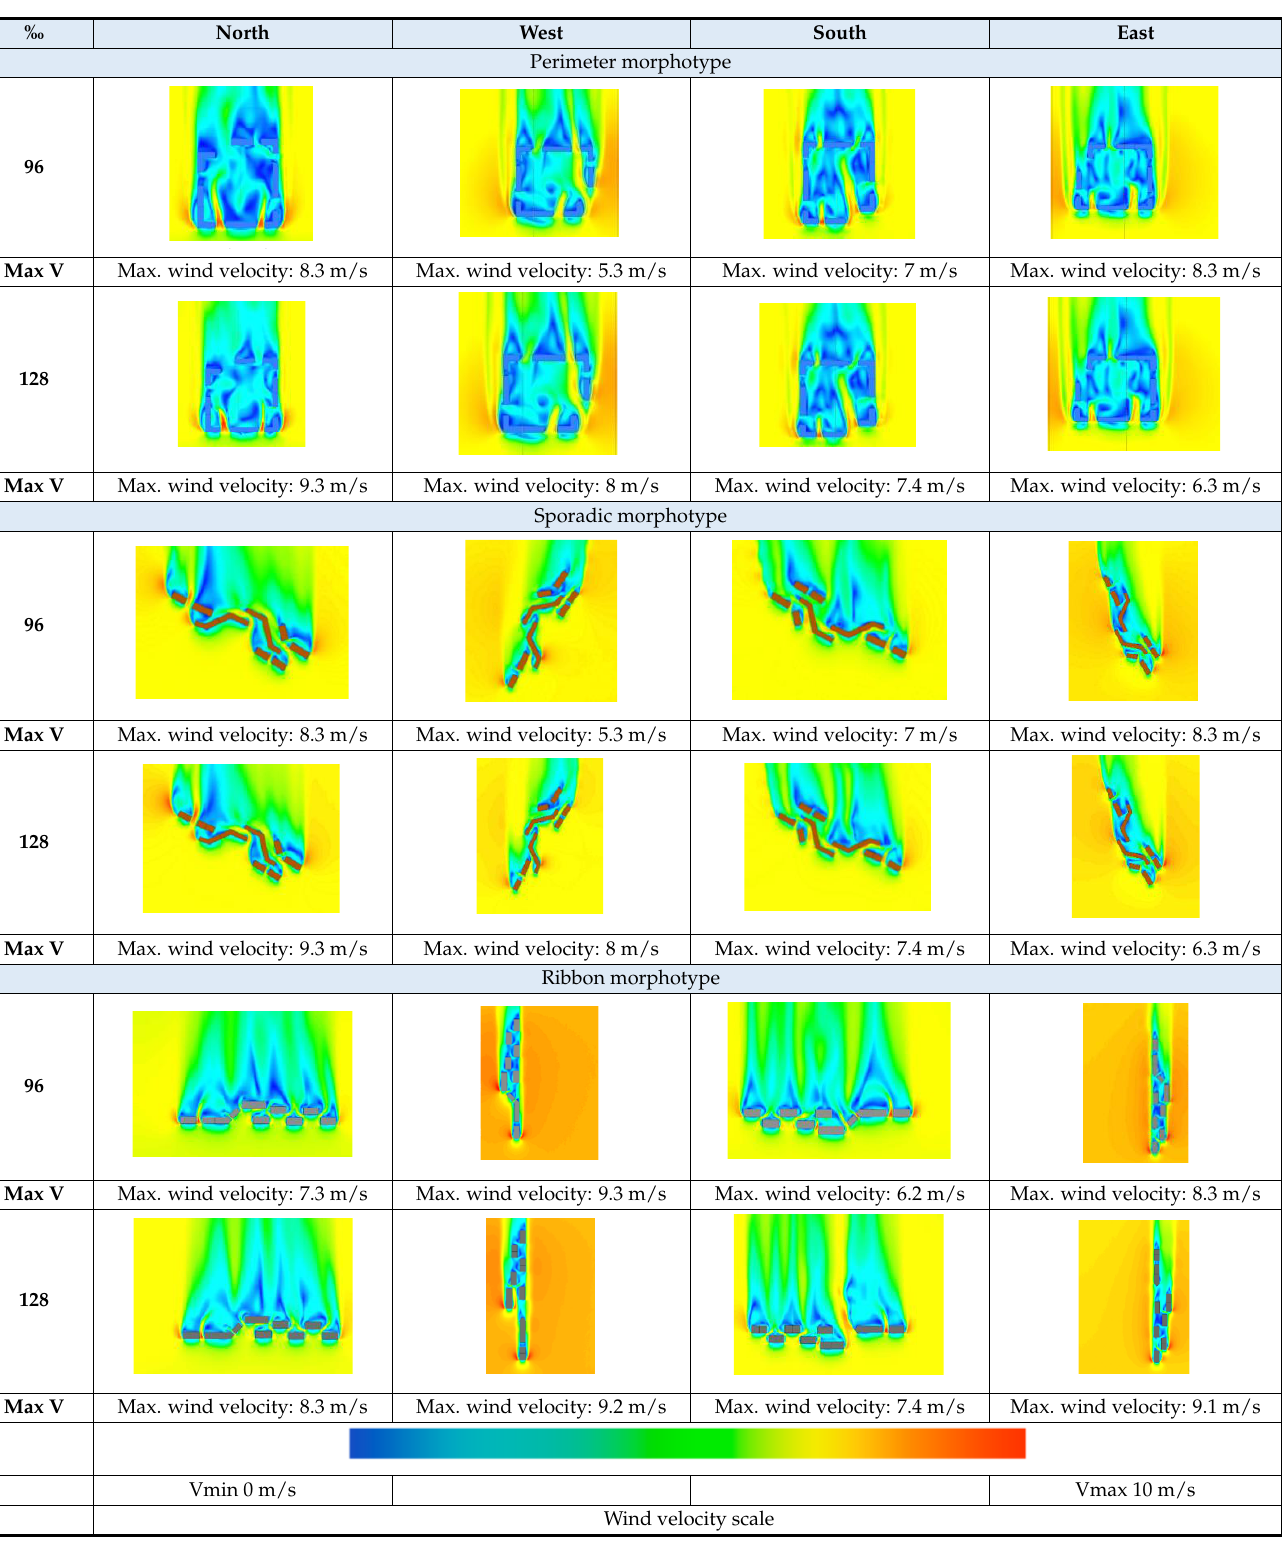
Table 4. Fragment of tables showing isopoles of wind flow velocities for perimeter, sporadic, and ribbon morphotypes.